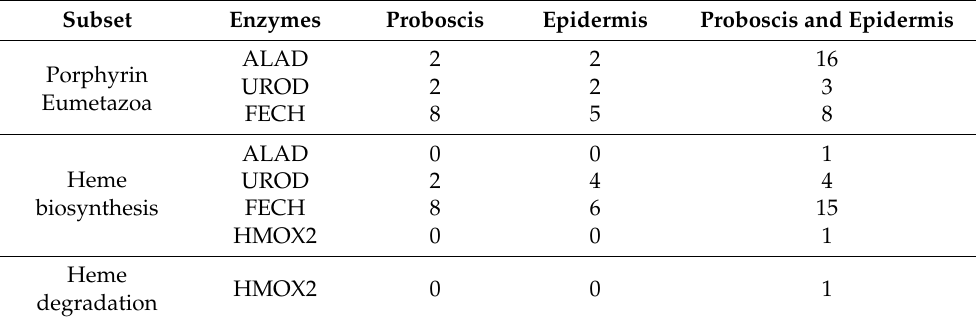
Table 2. Comparative numbers of highly abundant transcriptional variants (logTPM > 2) of heme- metabolism-related enzymes in the proboscis and epidermis of Eulalia after homology matching against the three Uniprot subsets (“porphyrin Eumetazoa”, “heme biosynthesis”, and “heme degra-